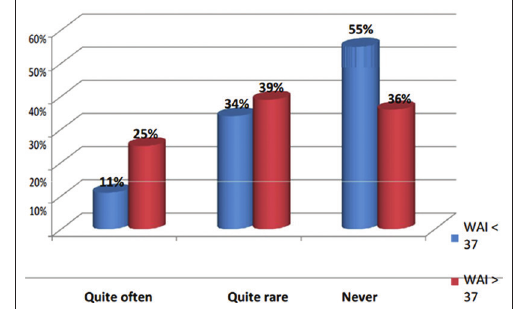
FIGURE 7. Work ability and opportunity for professional advancement. The majority of the employees with bad work ability (39 [55%]), has never had the opportunity to grow